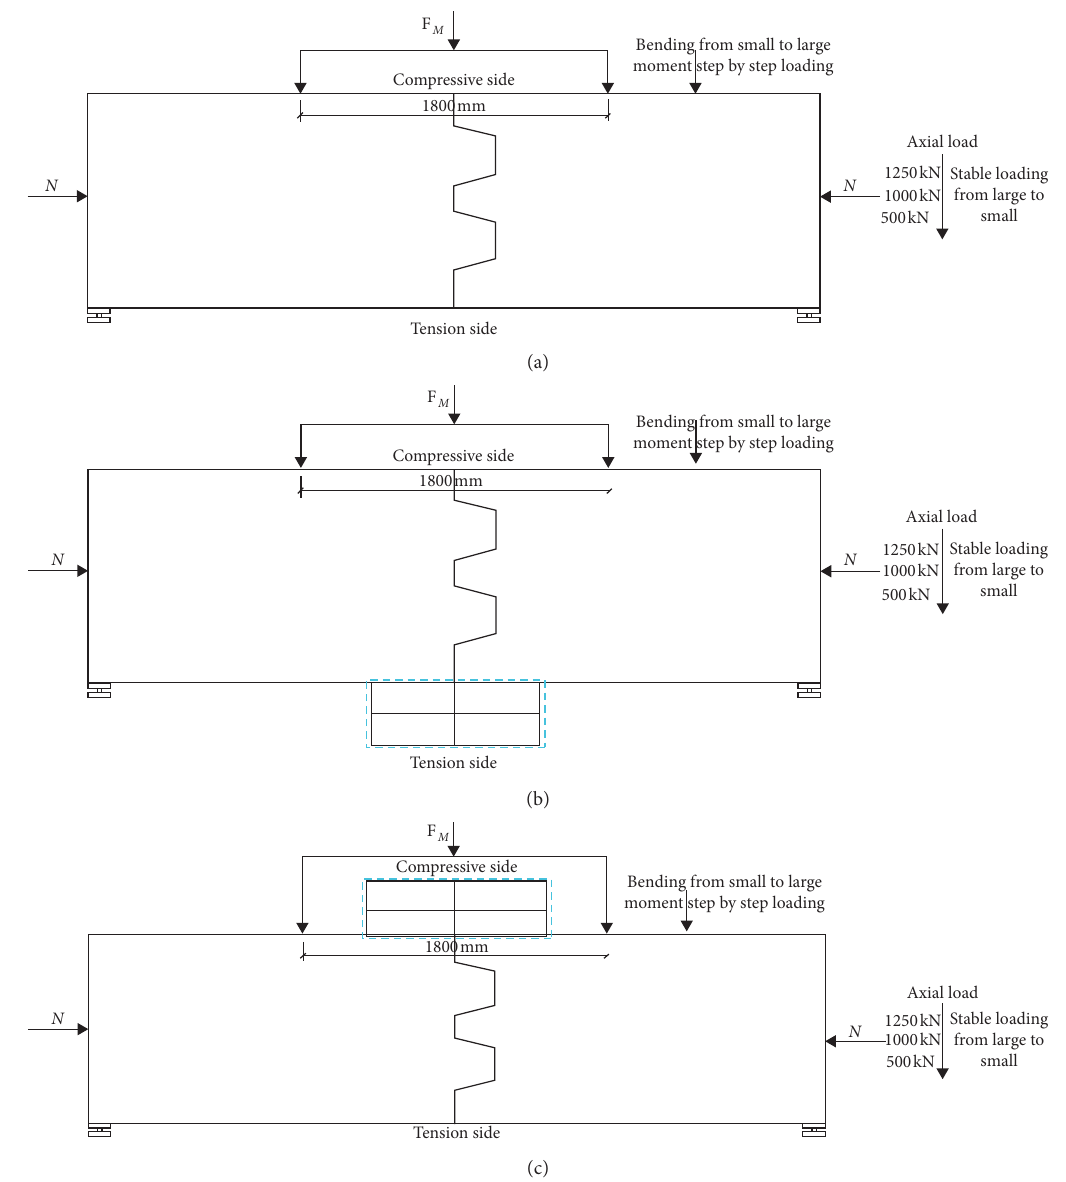
Figure 4: Layout for loading mode and sequence of specimens: (a) without auxiliary pretightening device; (b) auxiliary pretightening device on tension side; (c) auxiliary pretightening device on compression side.